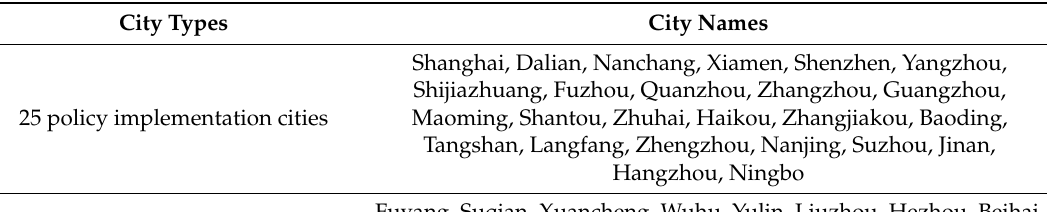
Table A1. 85 cities selected for DID estimation in this